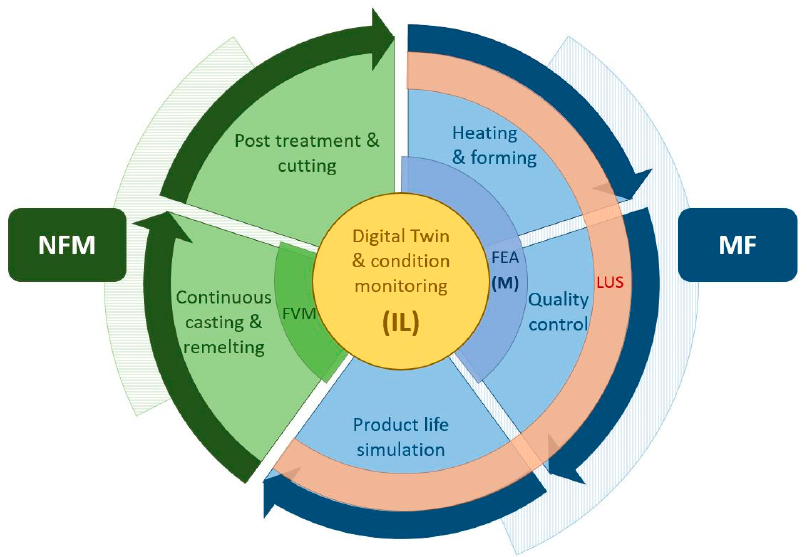
Figure 2. Visualization of the value chain covered in the SPL with the area covered by the LUS shown in orange. in